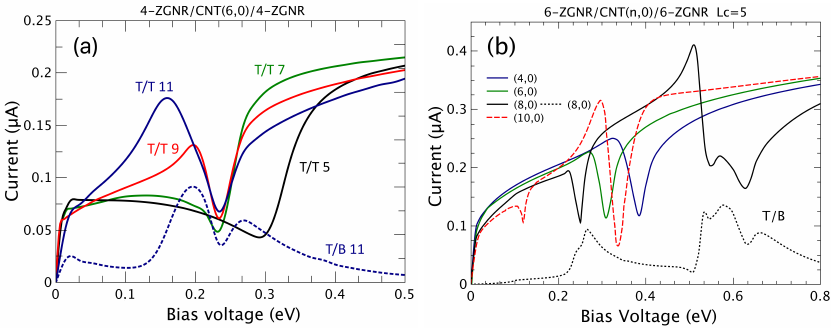
Figure 5. (Color online) Current (T/T) versus voltage potential for a ( a ) 4-ZGNR/(6,0)CNT/4-ZGNR system with L c = 5, 7, 9, and 11 and ( b ) 6-ZGNR/(n,0)CNT/6-ZGNR and fixed L c = 5 for different CNT radii ( n = 4, 6, 8, and 10). T/B currents are shown in the lower part of both figures for